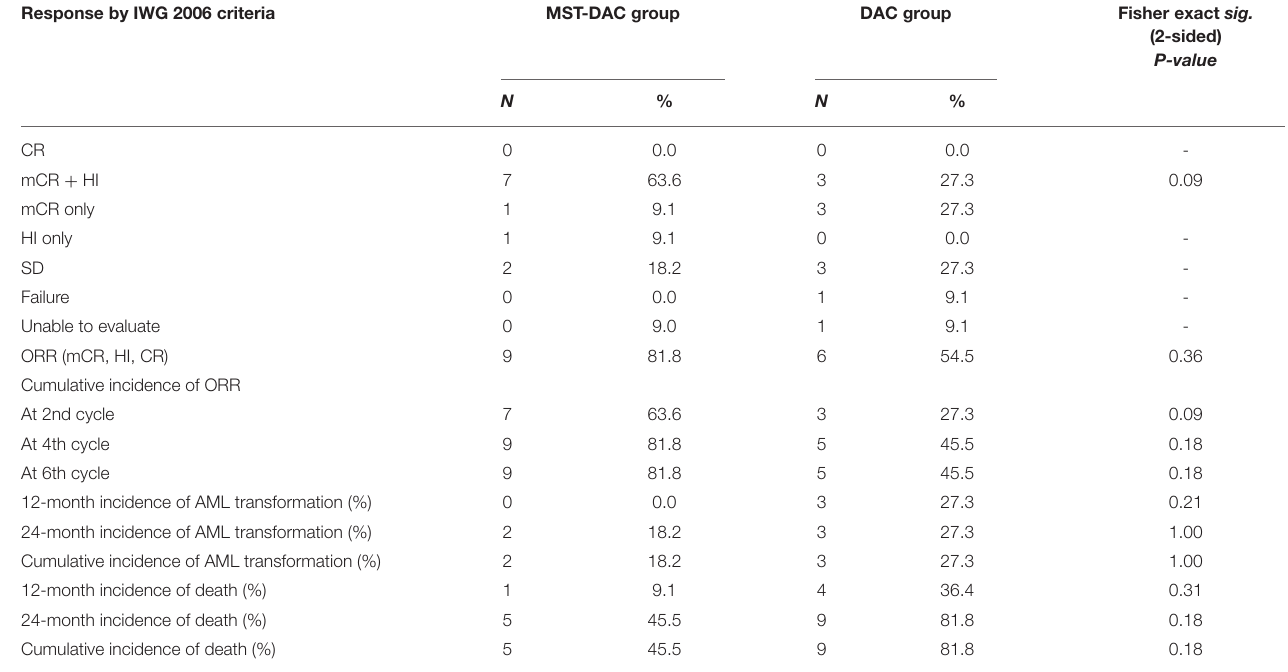
TABLE 2 | Patient outcomes. Response by IWG 2006